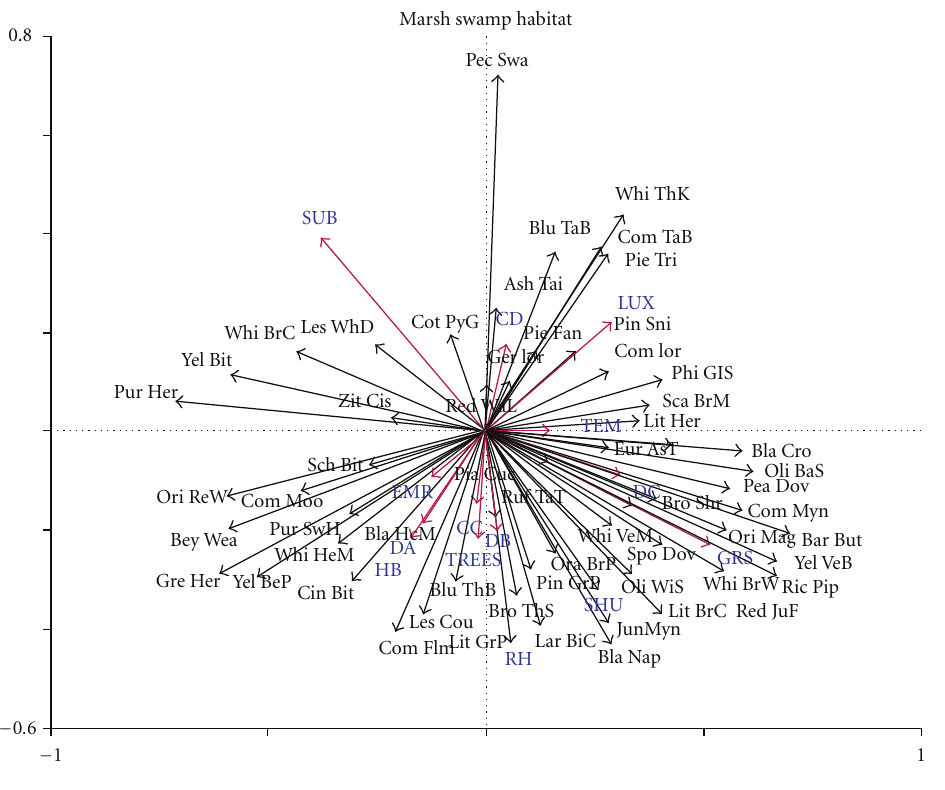
Figure 2: Ordination plot from a redundancy analysis of the distribution of birds of marsh swamp in relation to 14 environmental variables (for details see Table 2). The biplot of axes 1 and 2 is presented; the orientation of each variable in relation to each of these axes is presented by an arrow, the length of which indicates the degree of correlation with those